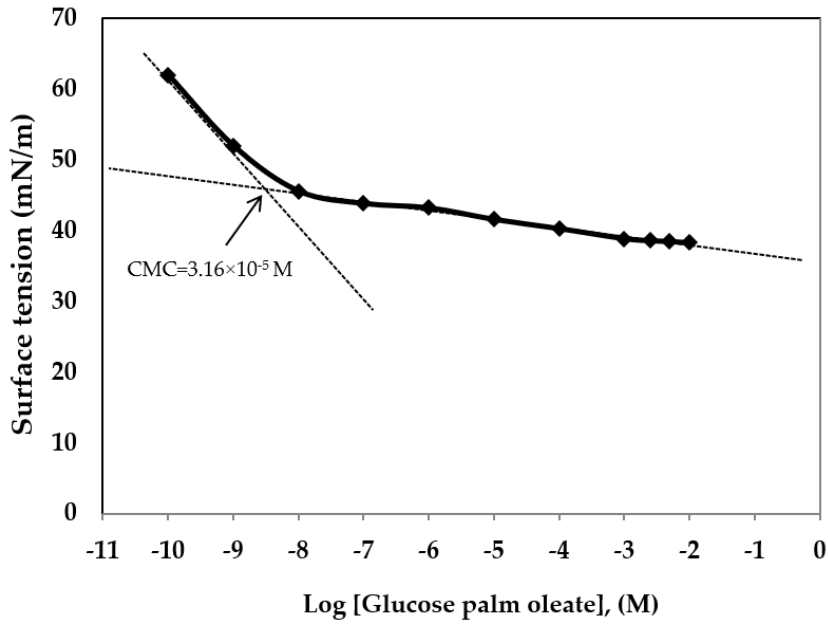
Figure 7. Mean surface tension measurements of glucose palm oleate solution with the corresponding log concentration and indicating CMC point.